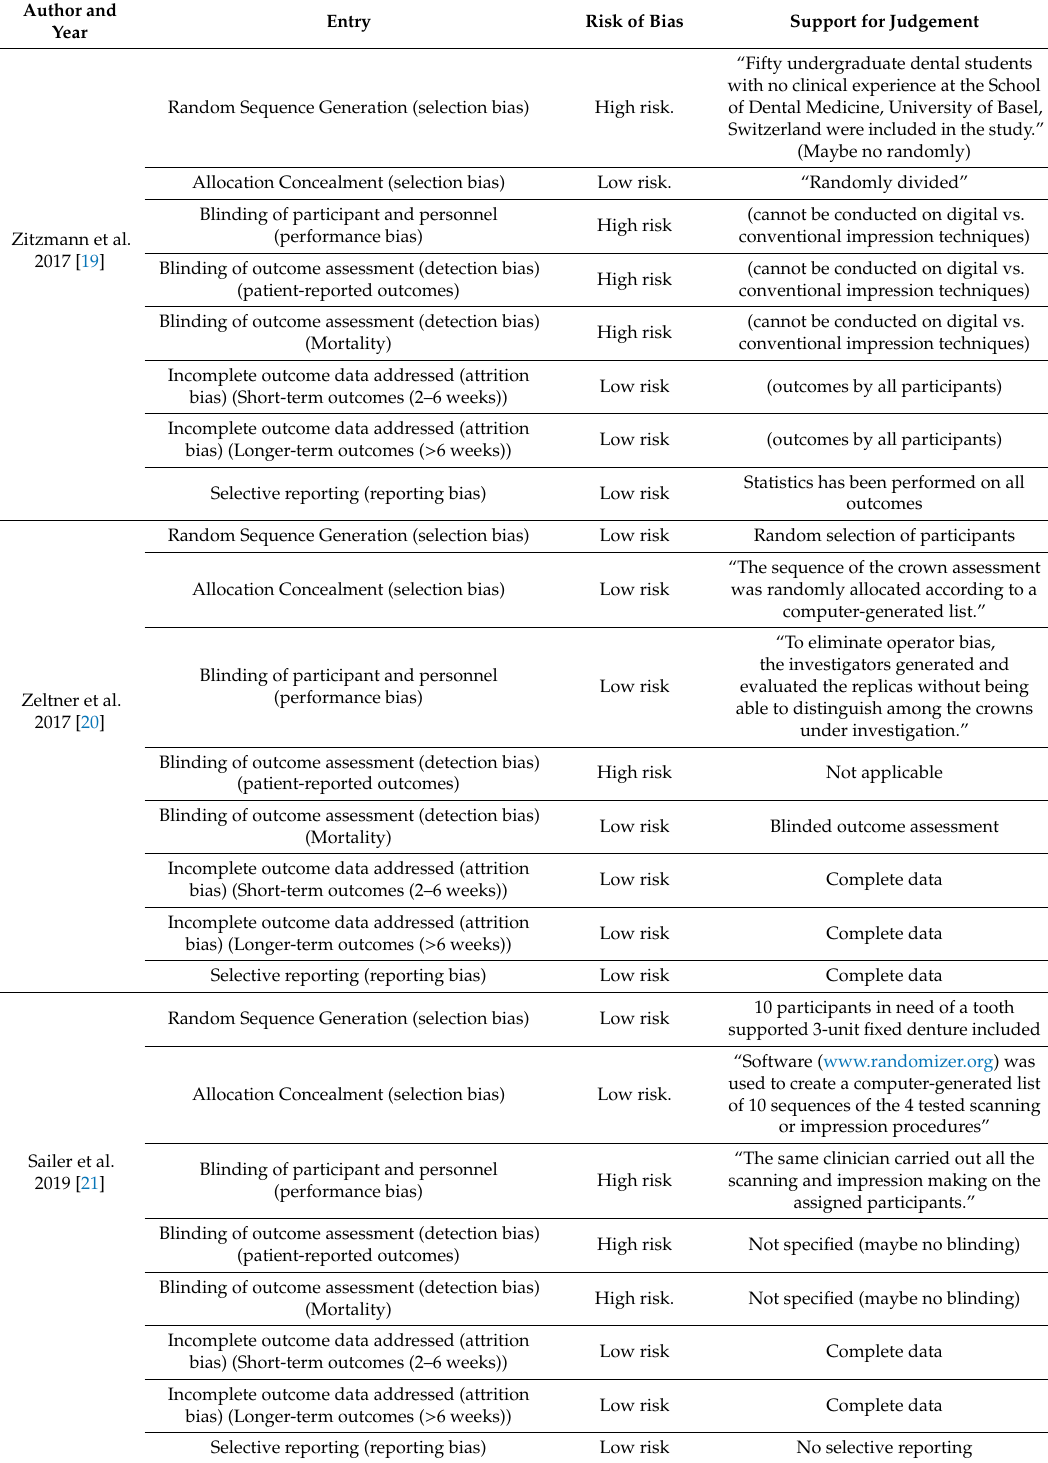
Table 2. Risk of bias according to Cochrane